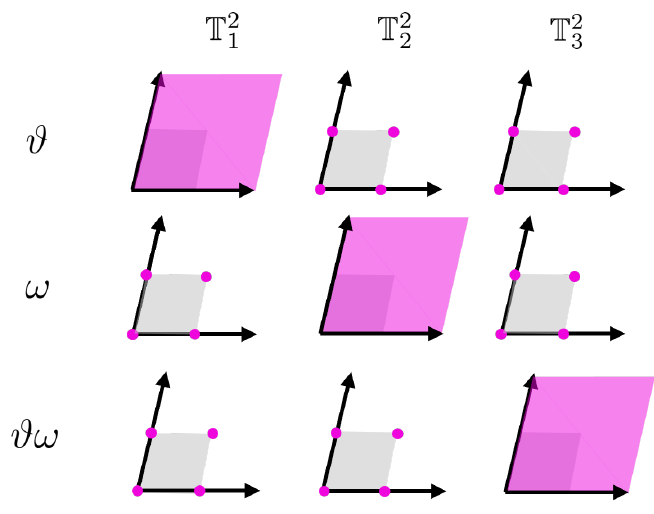
Figure 12 . An illustration of the fixed points (pink) in the Z 2 × Z 2 − 1 − 1 orbifold.